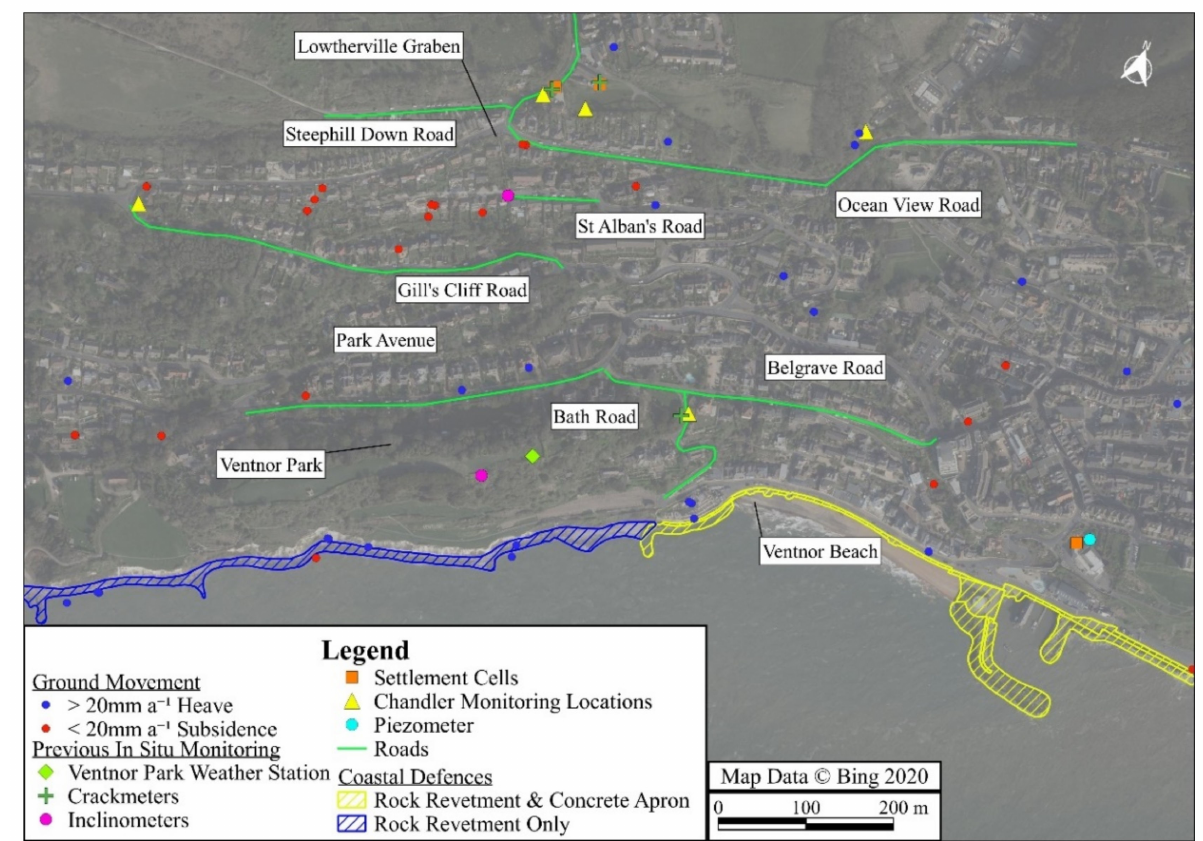
Figure 7. PS at Ventnor showing large heave/subsidence in both orbits (V LOS > 20 mm a − 1 and V LOS < − 20 mm a − 1 ) in 2016. The image was created on QGIS with background imagery from Bing Maps